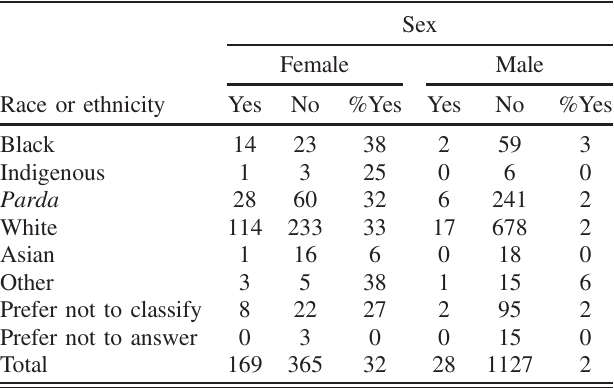
TABLE III. Number and percent of people who reported having suffered sexual harassment, within the subgroups of race and sex. Composition of respondents according to academic degree, compared to the composition of SBF affiliates.